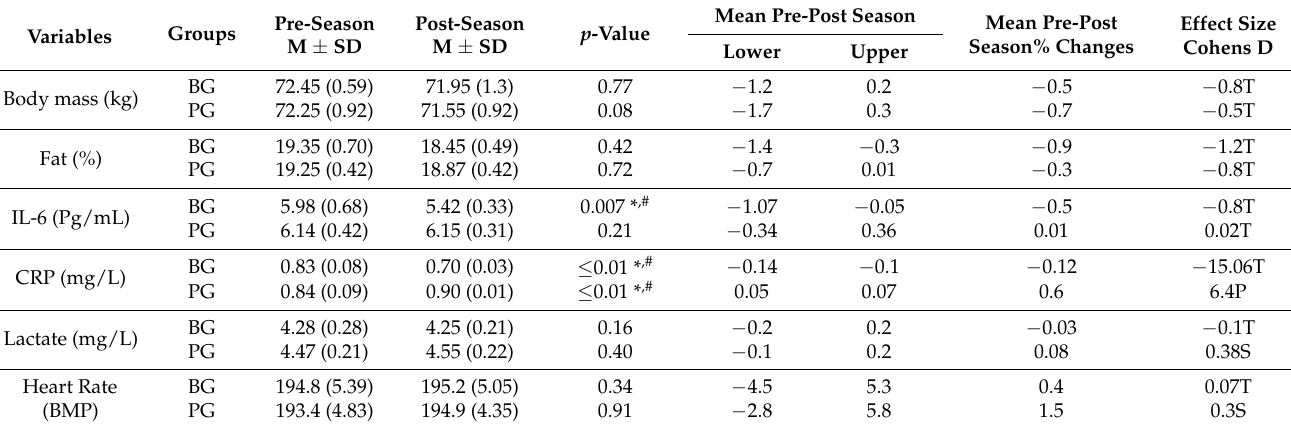
Table 2. Changes of cytokines levels and body composition during pre-, mid-, and post-season.